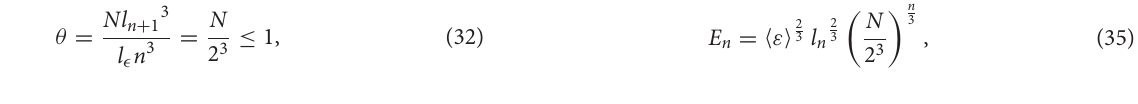
1; (C) ξ 1.5; and (D) ξ = =